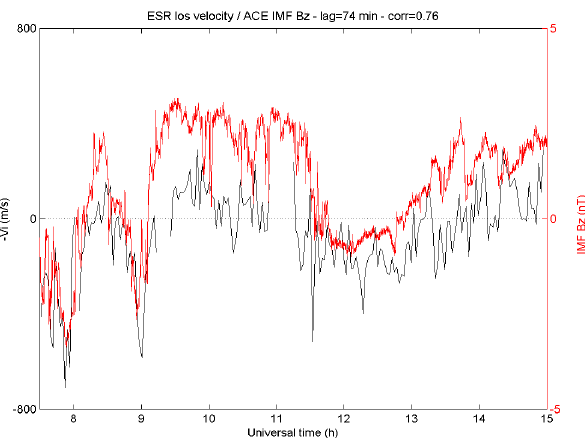
Fig. 10. Lagged Z -component of the Interplanetary Magnetic Field (red) and the latitudinal plasma velocity measured by the ESR at geographic latitude 82 ◦ (black) versus time between 07:30 and 15:00UT. Best correlation (0.76) obtained for a magnetic field lagged by